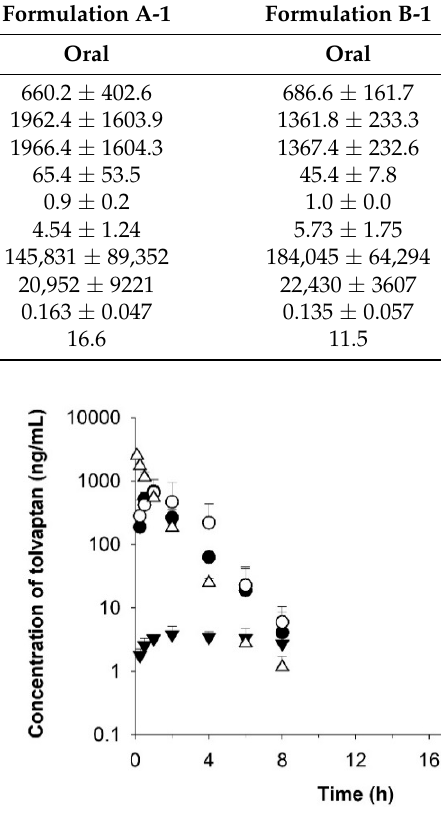
Figure 7. Temporal profiles of tolvaptan concentrations in rat plasma after oral administration of optimized formulations A ‐ 1 ( ○ ) and B ‐ 1 ( ● ) and raw tolvaptan powder ( ▼ ) at a dose of 30 mg/kg and after intravenous administration of raw tolvaptan powder ( △ ) at a dose of 5 mg/kg. Data are shown as the mean ± SD ( n = 4).